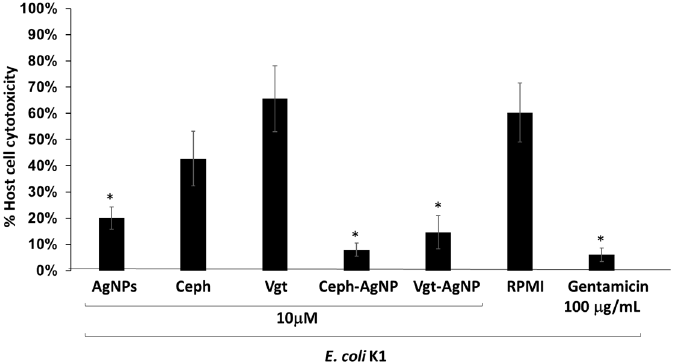
Figure 5. Cytopathogenicity assays were performed using E. coli K1 as described in materials and methods. Briefly, bacteria were incubated with test samples for 2 h before putting on HeLa cells monolayer with and without different drugs (10 µM), Cephradine (Ceph) and Vildagliptine (Vgt). Cells were then incubated for 24 h on standard conditions. Untreated bacteria, and bacteria treated with gentamicin were also treated with cells to evaluate their effects on cells cytotoxicity. Triton-X was used to lyse cells before determination of lactate dehydrogenase (LDH) release as marker of cell damage. LDH was determined by using Roche applied sciences LDH kit supplemented with enzyme and buffer. The % cytotoxicity was calculated by formula: % cytotoxicity = (sample value − control value)/total LDH release − control value) × 100. The results are representative of at least three independent experiments performed in duplicates. Asterisk indicates p < 0.05 using t -test, two-tailed distribution.